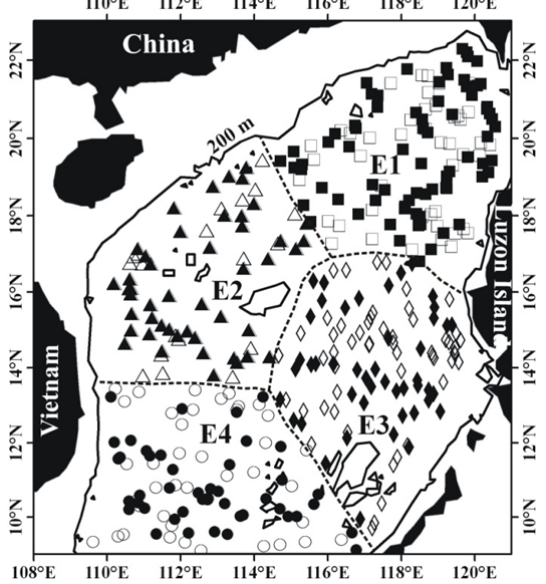
Fig. 4. Four-cluster results. The dashed lines schematically depict the boundary of the four regions. Symbols of anticyclonic eddies are unfilled while those of cyclonic eddies are filled with black. Dif- ferent groups are distinguished by different geometry shapes.